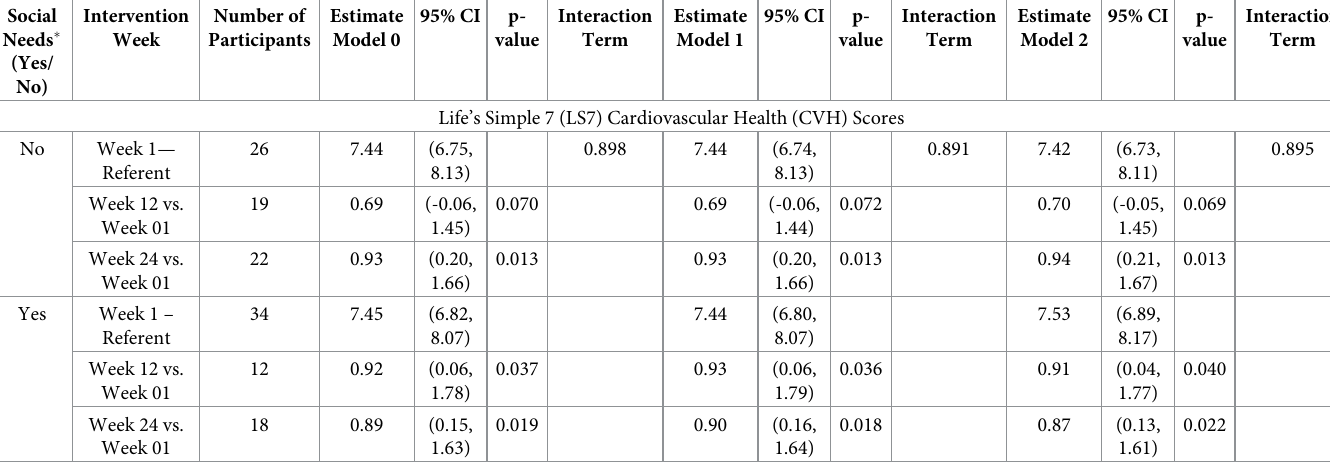
Table 3. Longitudinal change of cardiovascular health scores at Week 12 and Week 24 stratified by baseline non-medical health-related social needs